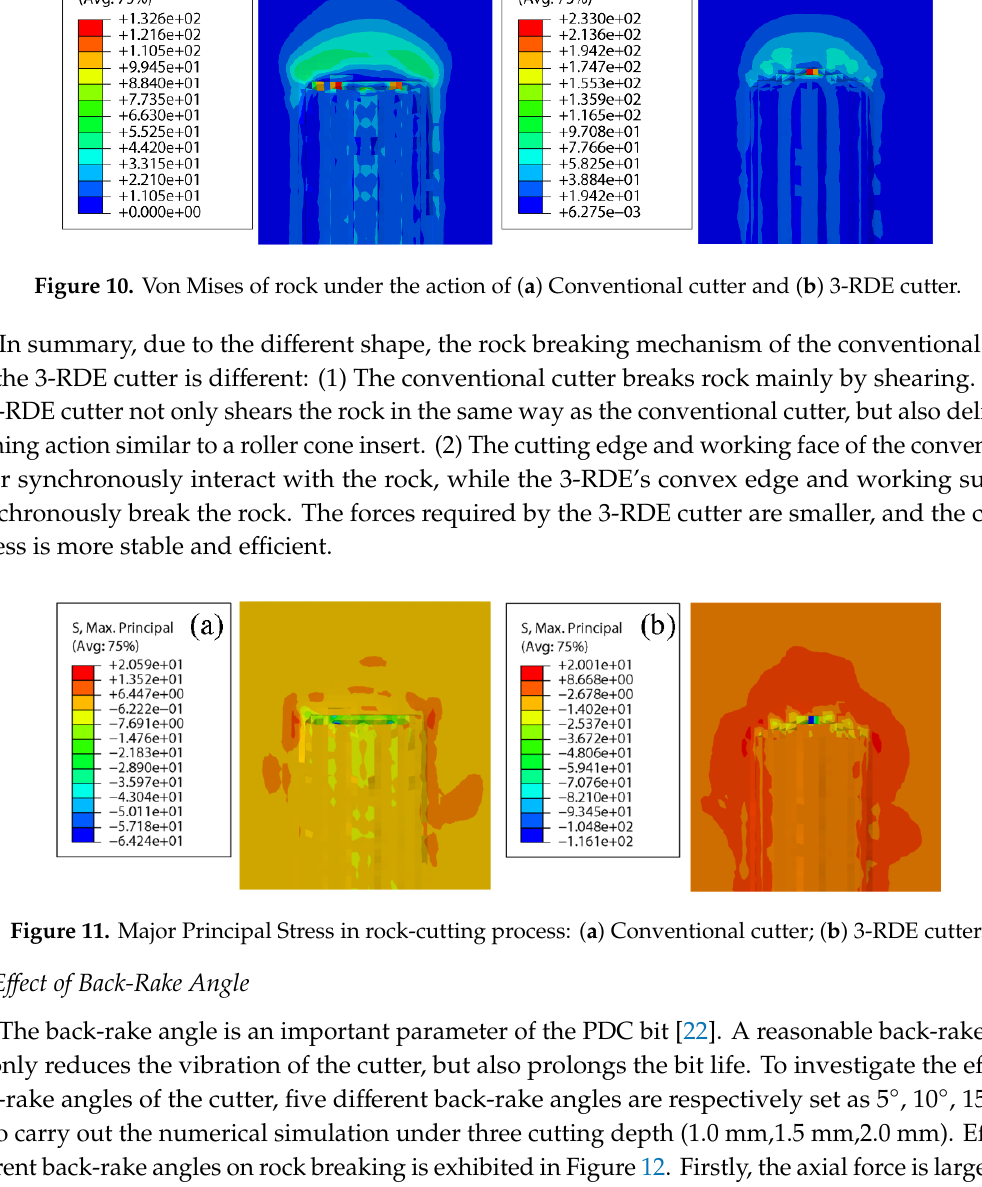
Figure 11. Major Principal Stress in rock-cutting process: ( a ) Conventional cutter; ( b ) 3-RDE cutter.